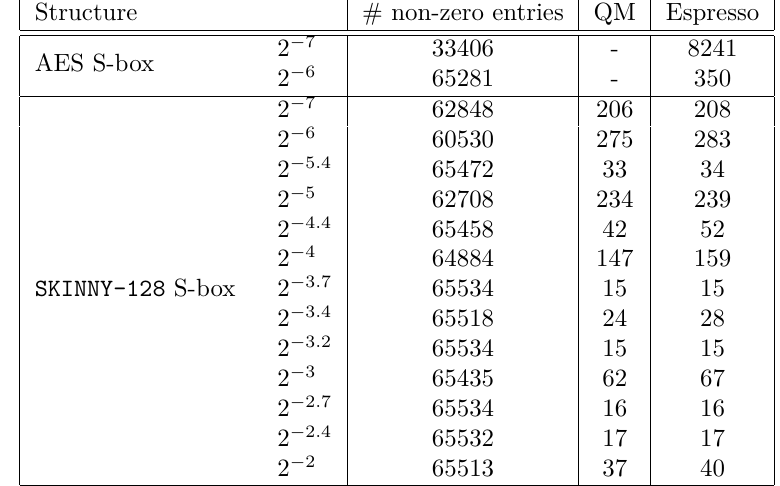
Table 6: Number of constraints to represent pb -DDTs of AES and SKINNY-128 S-boxes.